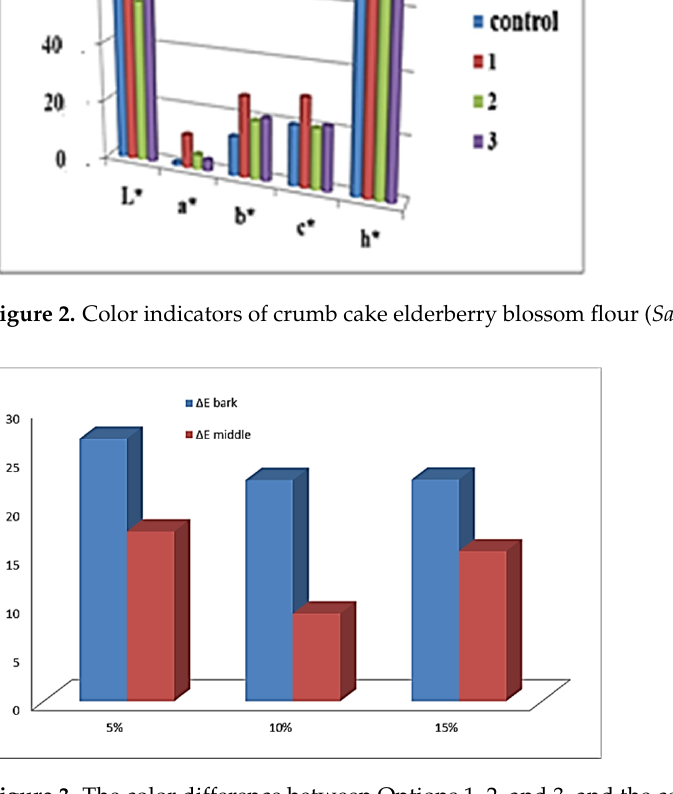
Figure 3. The color difference between Options 1, 2, and 3, and the control for the crust and crumb